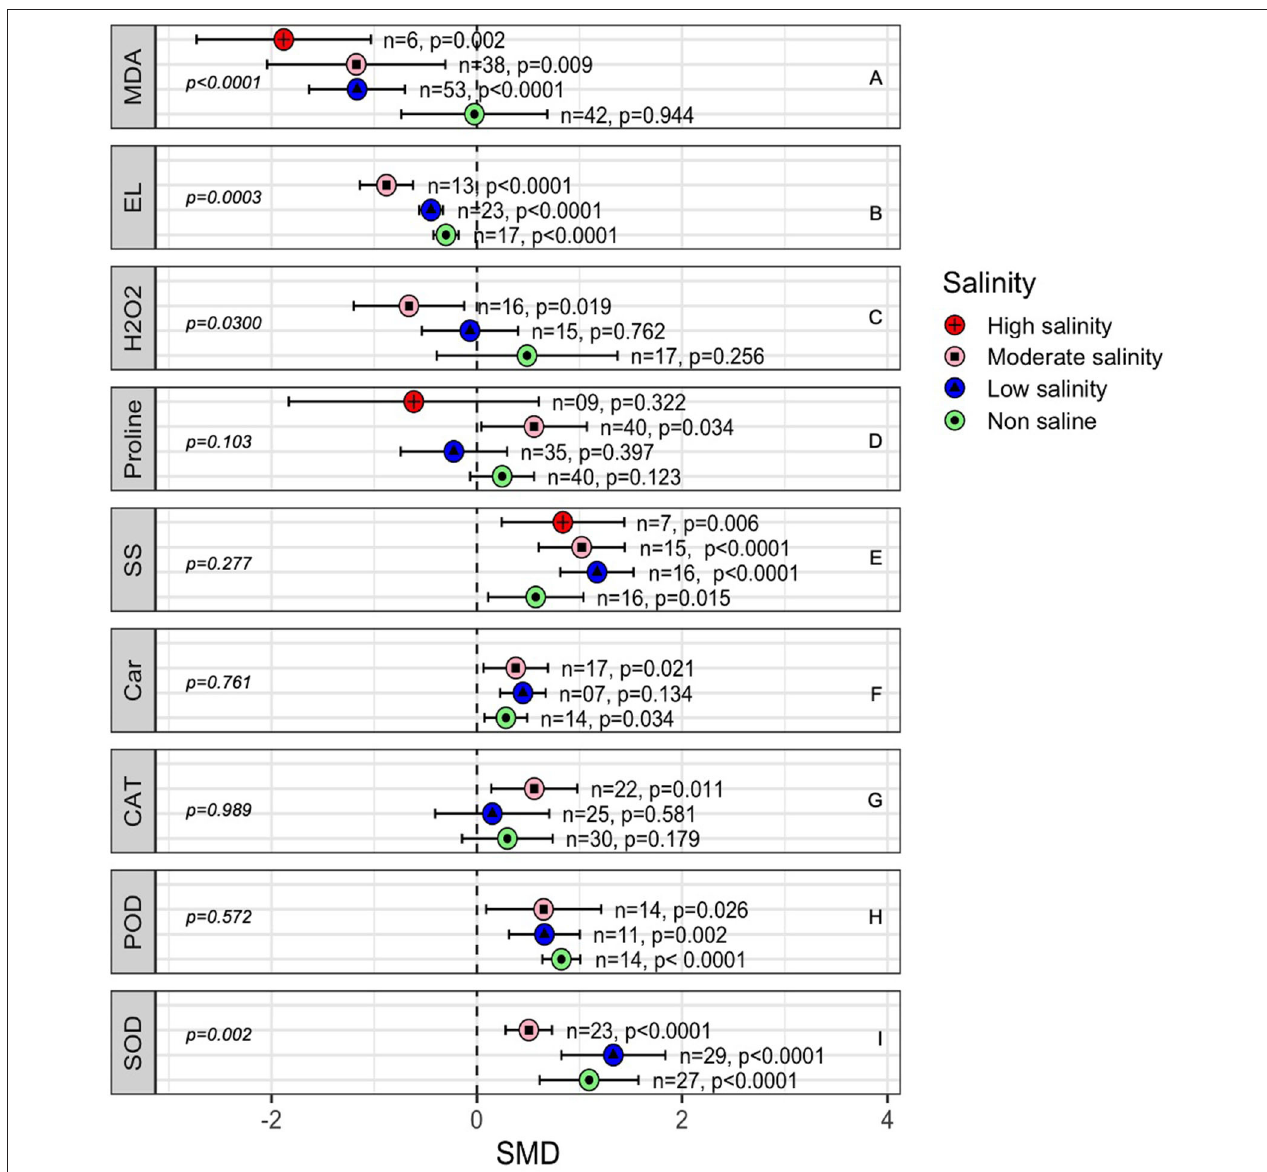
FIGURE 9 | Effects of mycorrhizae on plant enzymatic activity under non-stressed, low salinity, and moderate salinity stress. Error bars are means the CIs do not overlap the vertical dashed lines, the effect size for a parameter is significant. n , number of studies included in the meta-analysis. CAT, catalase; Car, Carotenoids; EL, electrical leakage; H2O2, hydrogen peroxide; MDA, malondialdehyde; POD, peroxidase and SOD, superoxide dismutase and SS, soluble sugars. n , number of studies included in the meta-analysis, p , significance level of